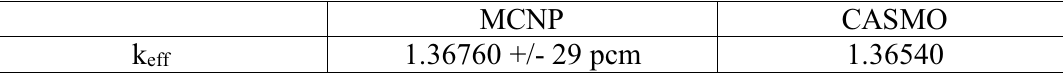
Table I. Multiplication coefficient for UOX core: MCNP and CASMO results.